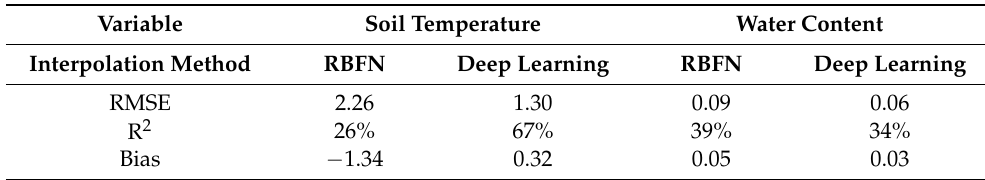
Table 4. Error analysis of soil temperature and water content values interpolated along the railroad using different AI models.